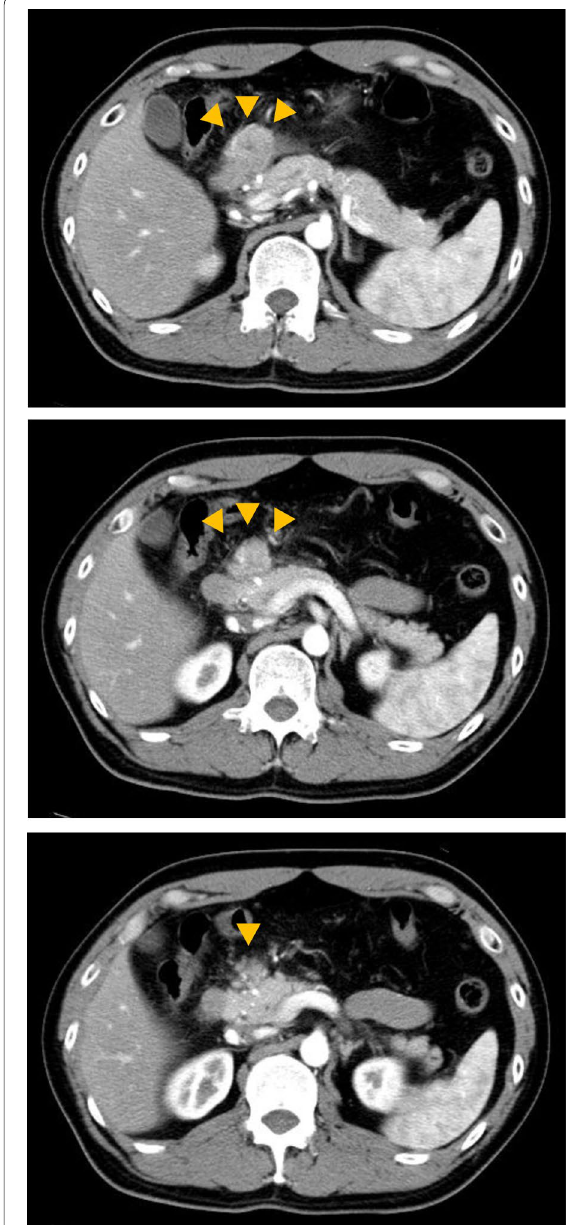
Fig. 1 Findings of abdominal computed tomography. CT revealed a 25-mm-large mass lesion with contrast effect from the anterior wall of the gastric pylorus to the duodenum (yellow arrow). From the CT image, it is difficult to distinguish the continuity between the tumor and the pancreatic head, which looks more like a tumor. CT computed